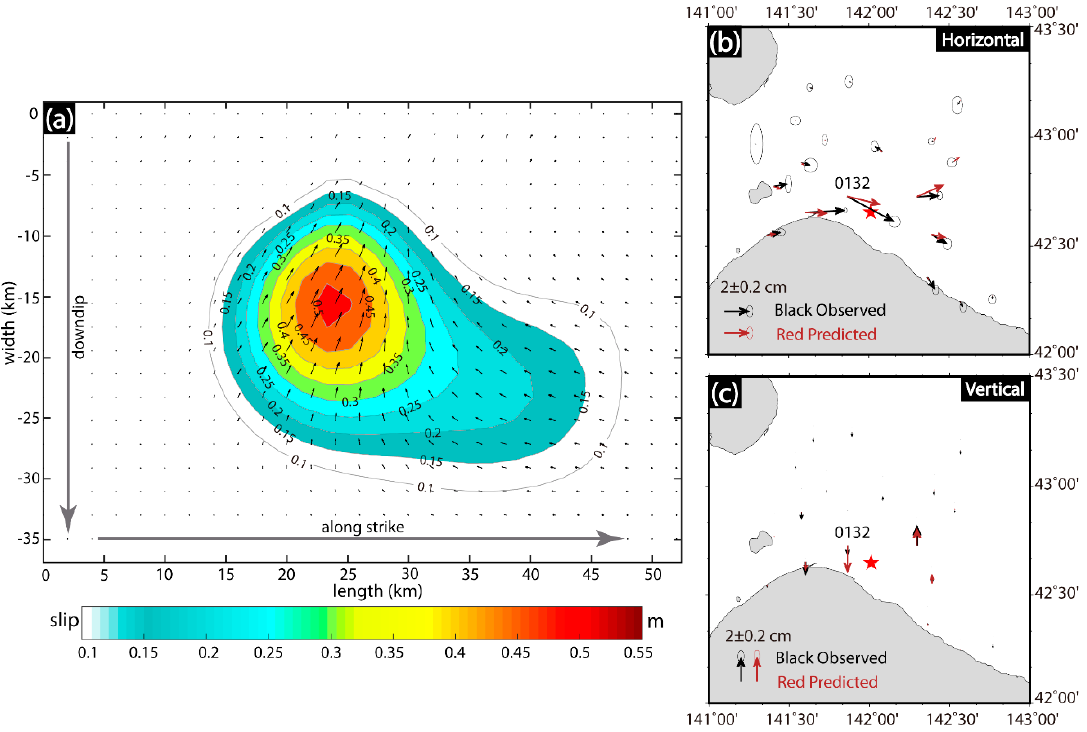
Figure 7. Two-dimensional (2D) coseismic slip model in the downdip direction and along the strike of the seismogenic fault for the 2018 Iburi event ( a ). Observed and predicted GPS coseismic displacements (horizontal ( b ) and vertical direction ( c )).